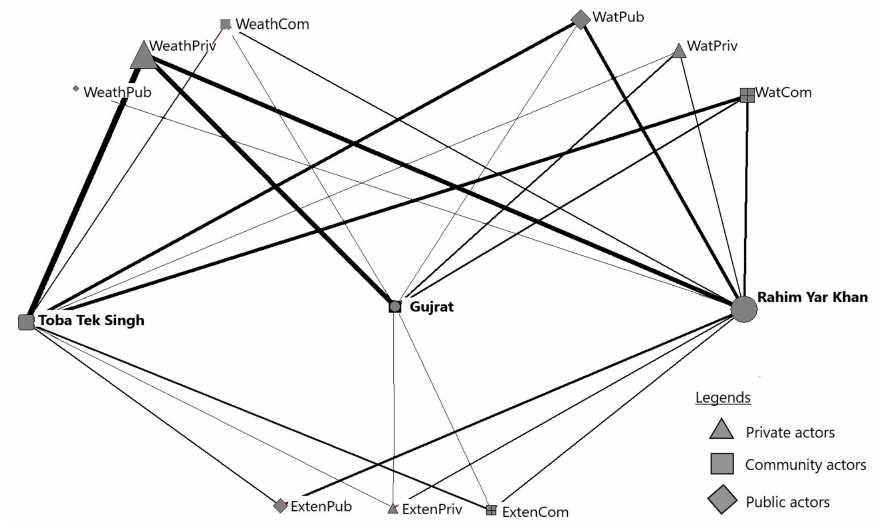
Figure 4. Social network showing linkages from farmers to climate adaptation knowledge sources. Thick and bold links represent higher link densities between actors, while actor size is an indication of the number of linkages an actor has in the network. The type of line indicates how strong or weak the linkage is in the network. Similarly, an actor with more connections with other actors appears bigger compared to actors with fewer connections in the network.